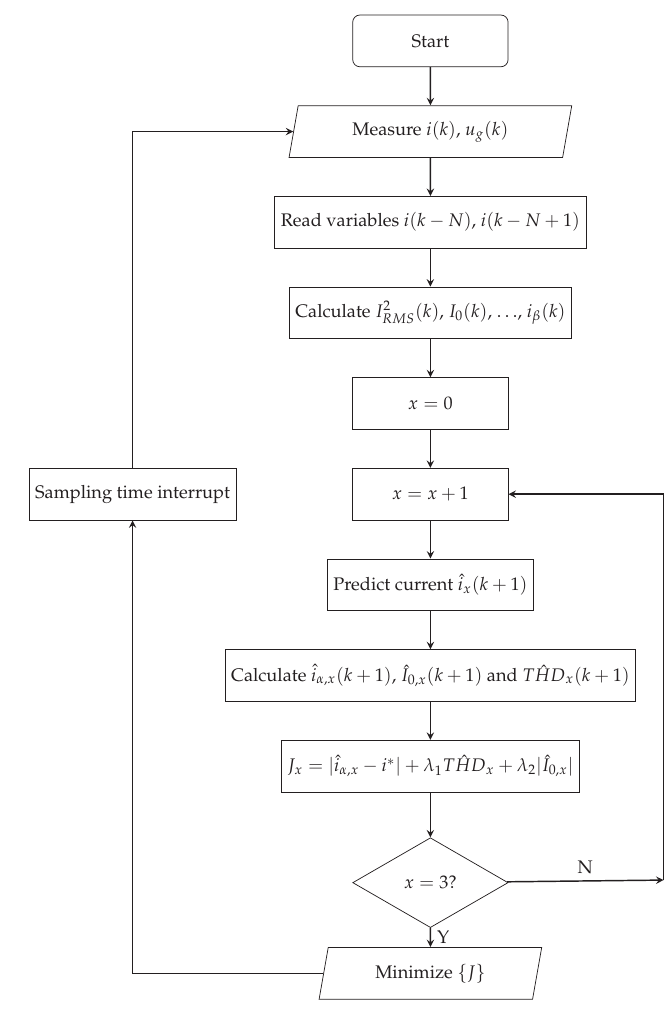
Figure 5. Control